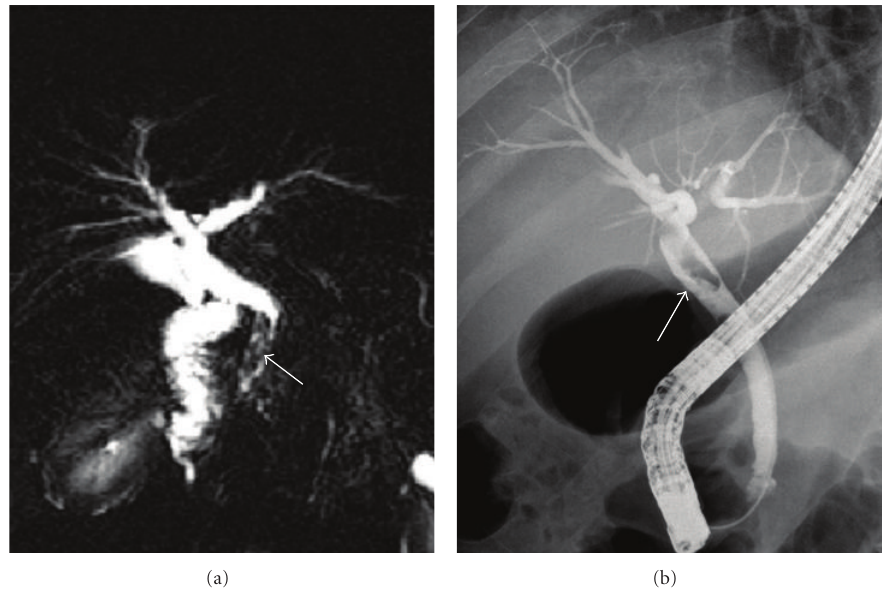
Figure 3: MRCP image demonstrates an irregular heterogenous hypointense region in the distal common bile duct (arrow). On MRI, this region evaluated as benign pathology such as calculus and sludge. ERCP image demonstrates a filling defect in this region (arrow). This filling defect was determined as Fasciola hepatica and extracted during the